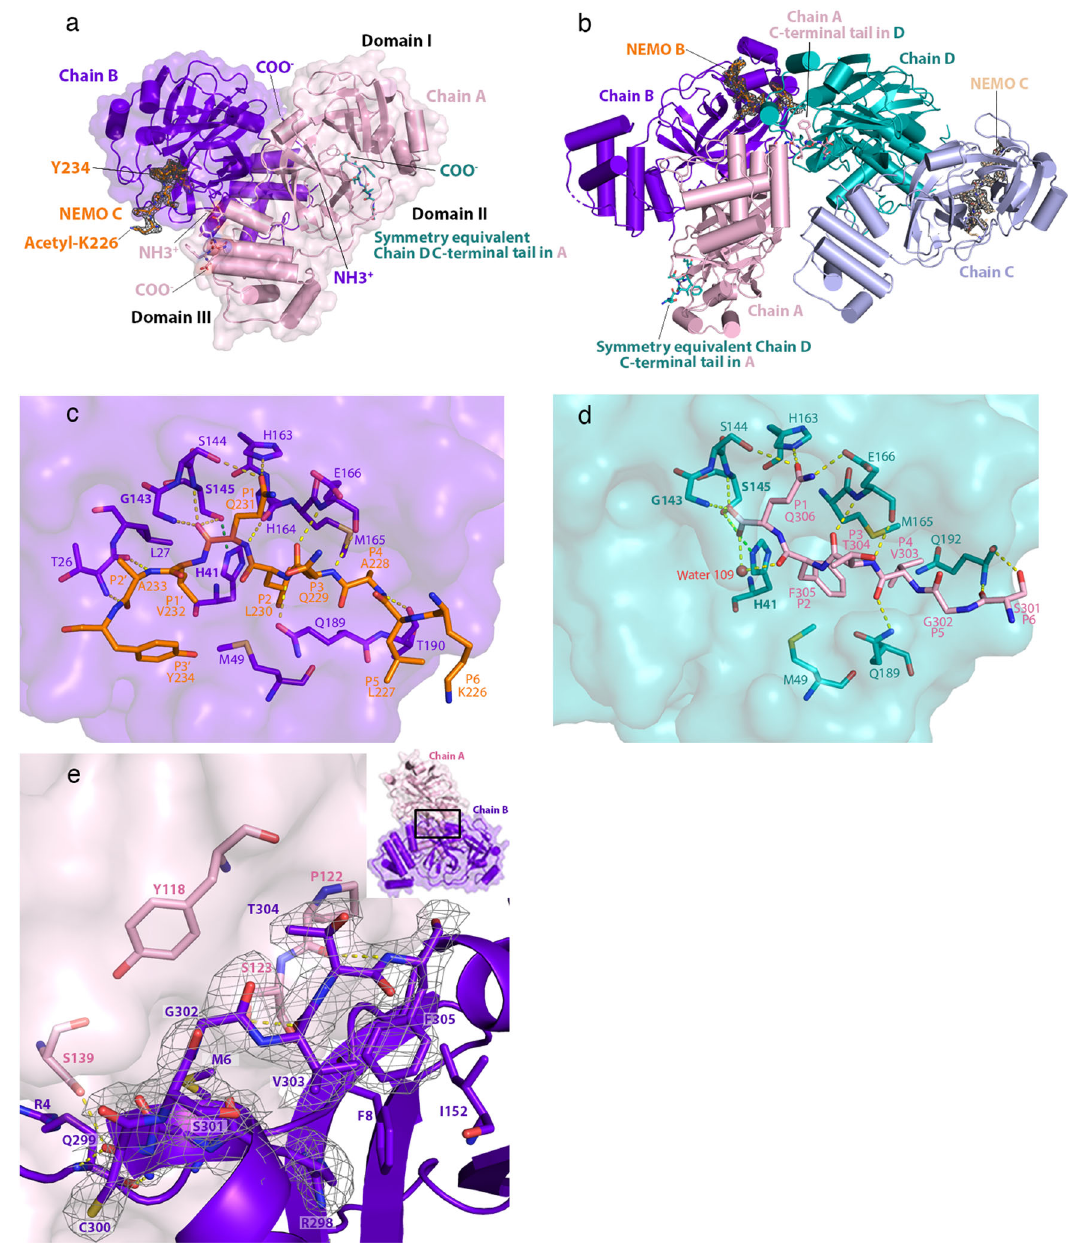
Fig. 2 | Structure of the hNEMO-bound 3CLpro C145S homodimer. a The hNEMO 226 – 234 -bound 3CLpro dimer. N- (NH3+) and C-termini (COO-) are labeled. hNEMO 226 – 234 (NEMO B - orange) binds into chain B (purple) and issurrounded by an omit map of electron density (1.0 σ contour level and 1.9 Å carving radius). AcetylatedLys226andTyr234attheN-andC-terminiofthehNEMO 226 – 234 peptide, respectively, are labeled. The C-terminal tail of chain D (teal) from a crystal- lographic symmetry equivalent binds into the substrate-binding site of chain A (lightpink).DomainsI,IIandIIIarelabeled. b StructureofthehNEMO-boundC145S variant asymmetric unit. The C-terminal tail of chain A (pink) binds into the substrate-binding site of chain D (teal). hNEMO peptides bound into chain B (purple) (NEMO B - orange) and chain C (light blue) (NEMO C - wheat) are super- imposed with an omit map (1.0 σ contour level and 1.9 Å carving radius) of their electrondensity. c InteractionsofhNEMO 226 – 234 withthesubstrate-bindinggroove of 3CLpro C145S. hNEMO 226 – 234 is colored orange. Residues Lys226 to Tyr234 are fullylabeled.ThesurfaceofchainB(purple)isshown.Substrate-bindingresiduesin